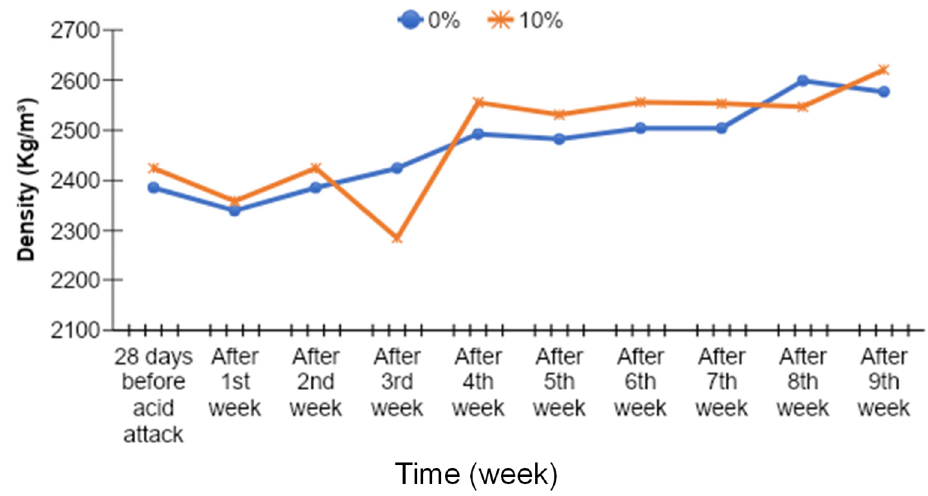
Figure 19. Comparison of density versus time curves for 0% (control) and 5% MK contents.